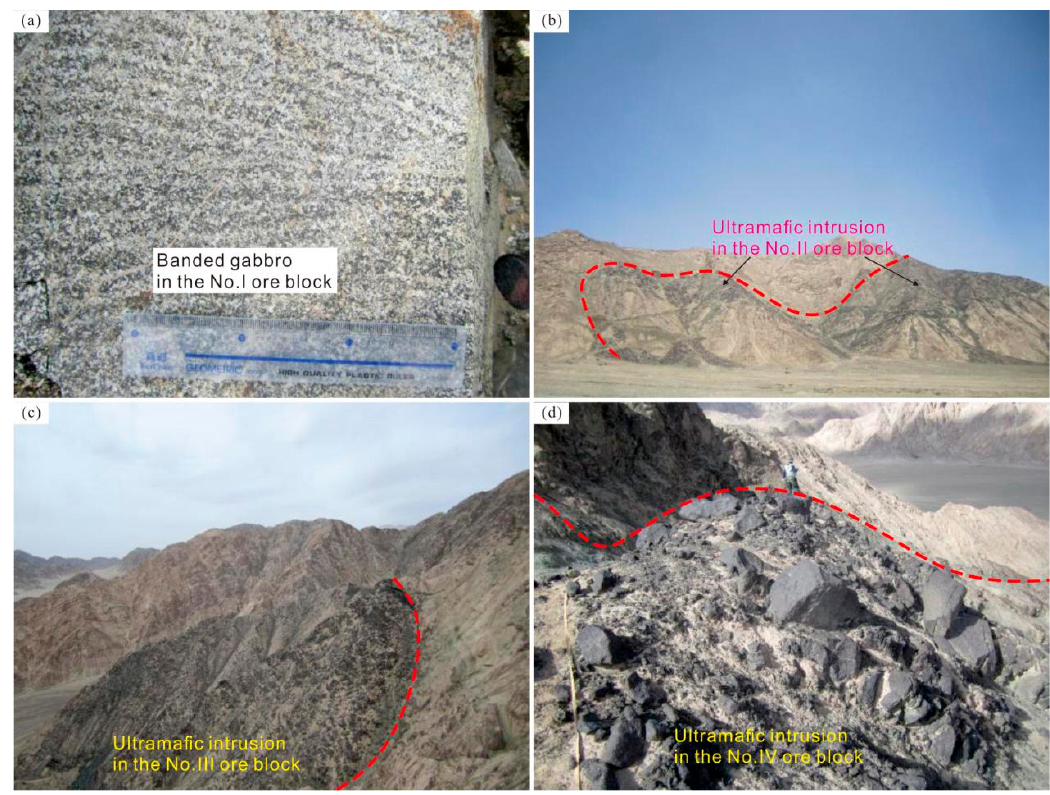
Figure 3. Representative field photographs of the Niubiziliang mafic-ultramafic complex. ( a ) Banded gabbro from the No. I ore block; ( b ) Ore-bearing ultramafic intrusion from the No. II ore block; ( c ) Ore-bearing ultramafic intrusion from the No. III ore block; ( d ) Ultramafic intrusion from the No. IV ore block.